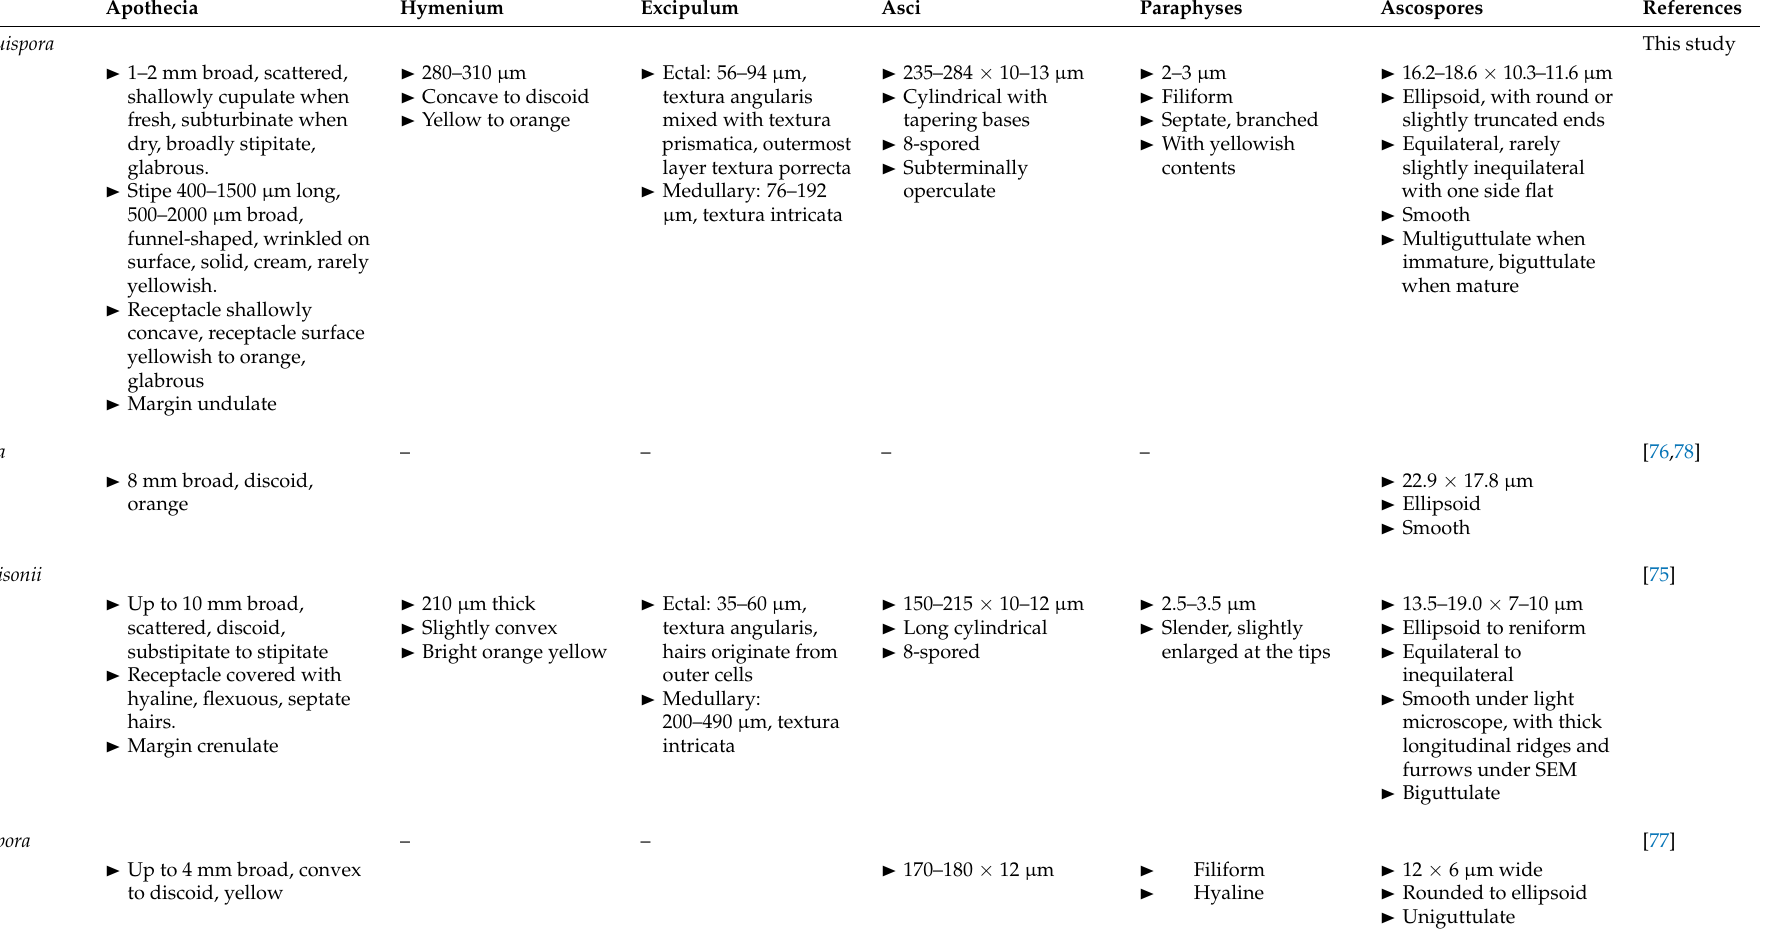
Table 2. Morphological characteristics of Nanoscypha